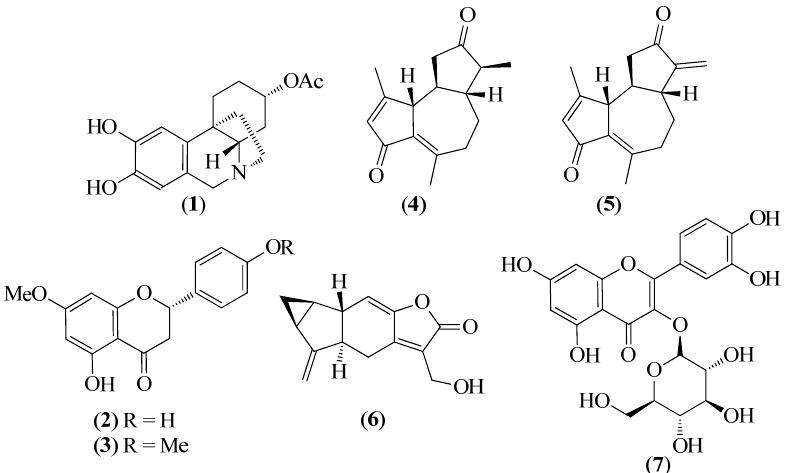
Pharmaceuticals 2021 , 14 , x FOR PEER REVIEW Figure 2. Structures of compounds 1 from Pseudodranassa spp., 2 and 3 from Baccharis obtusifolia , 4 and 5 from Gynoxis verrucosa , 6 from Hedyosmum racemosum , and 7 from Clusia latipes .